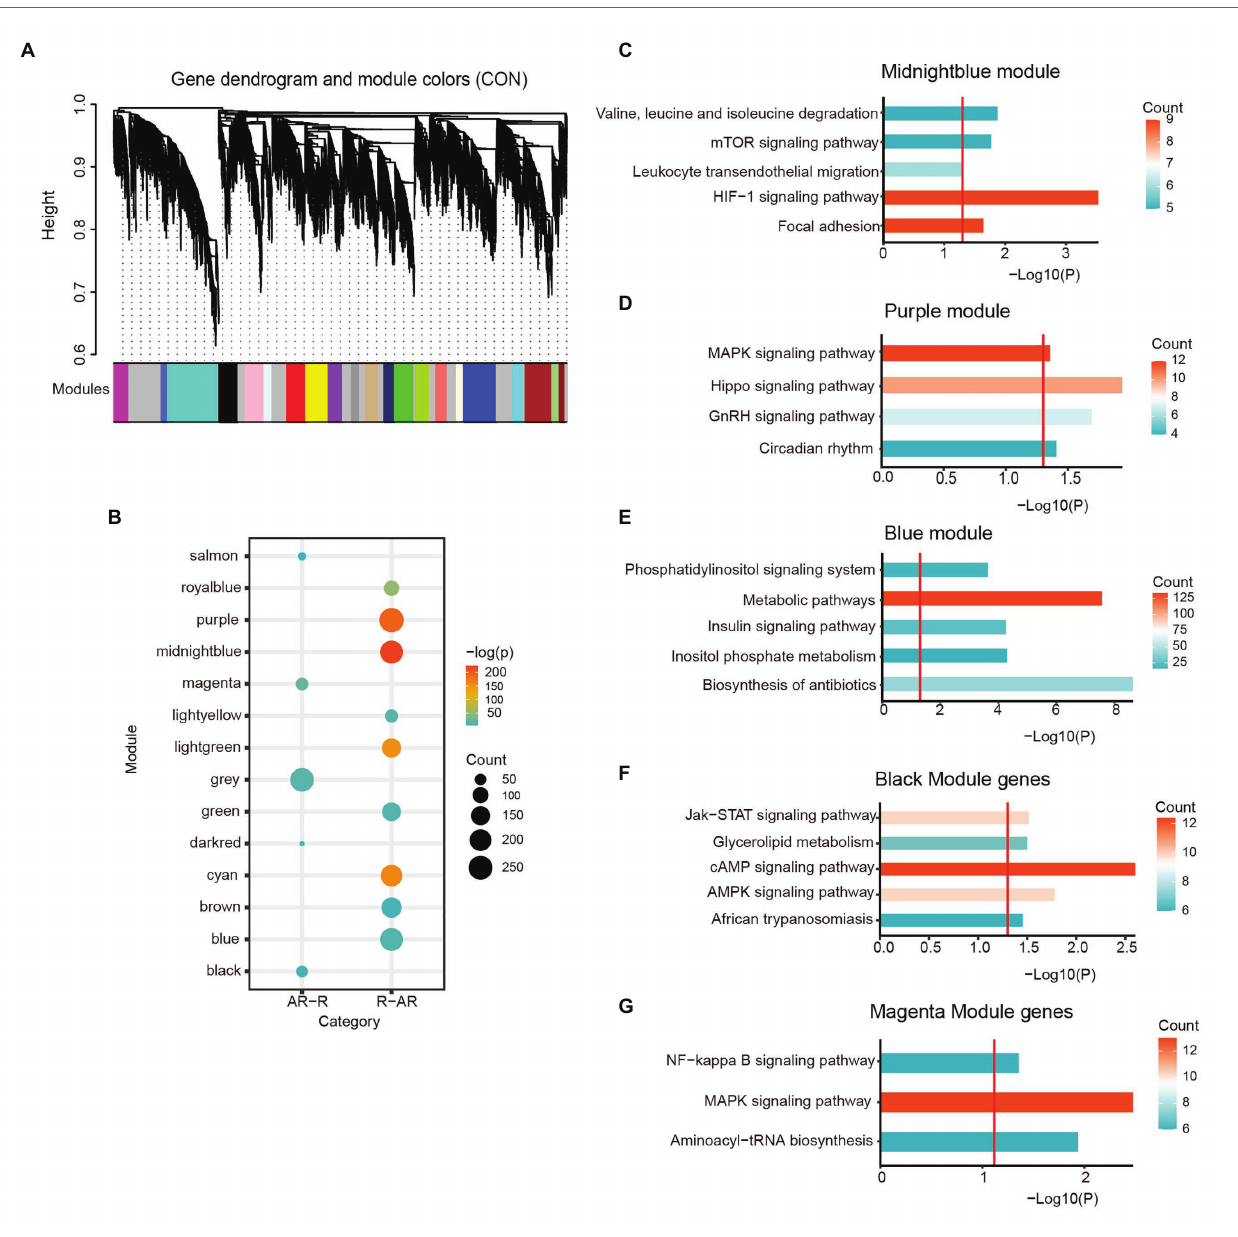
FIGURE 4 | Weighted gene co-expression network analysis (WGCNA) analyses on the circadian disrupted genes. (A) Hierarchical cluster analysis was conducted to detect co-expression clusters with corresponding color assignments. Each color represented a module in the constructed gene co-expression network by WGCNA. Twenty-two modules were identified and marked by colors on the horizontal bar. (B) Bubble plot showing enrichment of AR-R ( n = 712) and R-AR ( n = 2,272) genes in the main modules. Values of p were calculated using the Hypergeometric test. (C–G) Top ingenuity pathways associated with the midnight blue module (C) , the purple module (D) , the blue module (E) , the black module (F), and the magenta module (G) . Red threshold lines refer to p =